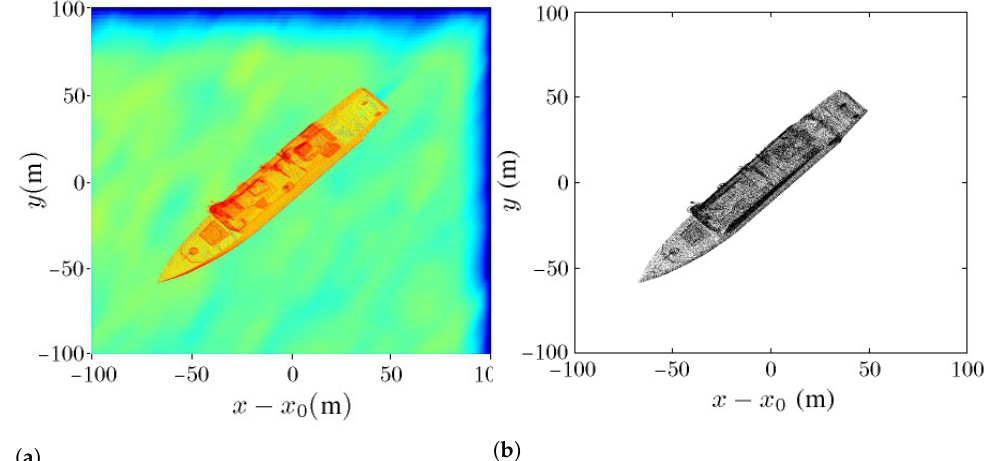
Figure 16. ( a ) Acquired image of Type 45 destroyer, in scale of (40, 90) dB and ( b ) scan image of 3D